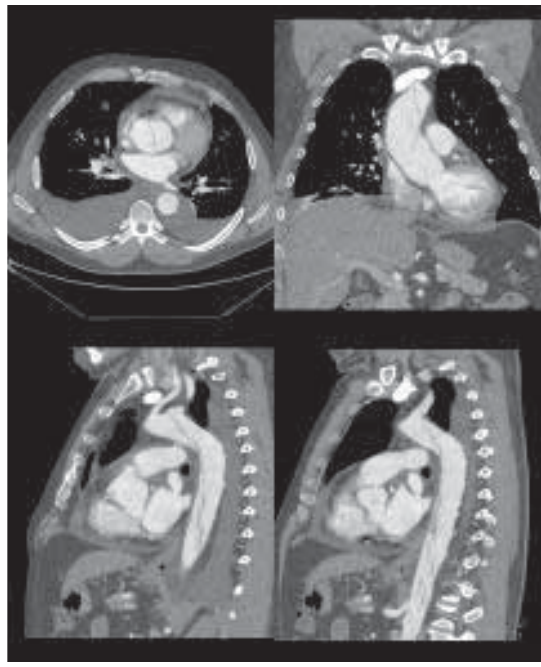
FIGURE 4. Dissection of thoracic aorta: Stanford type “A”